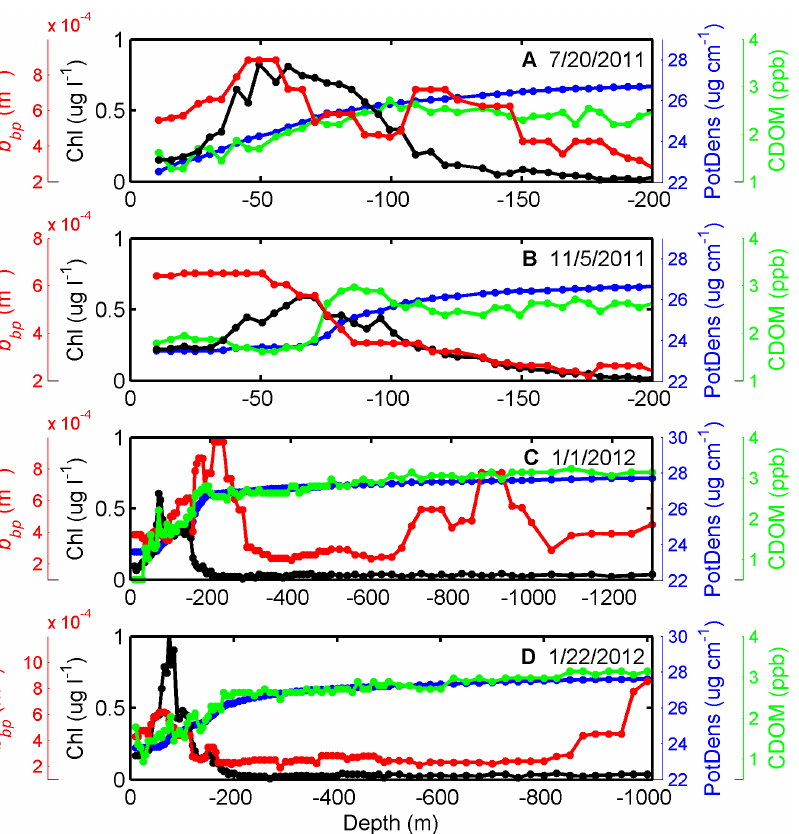
Figure 5. Float profiles exemplifying depth trends and peaks in b bp , Chl, CDOM, and potential density (PotDens). Examples each are provided of b bp peaks at the following depths: (A) coincident with and just below the DCM, (B) in a surface layer, (C) at intermediate depths (700 to 900 m), and (D) near-bottom. In panels A and B, only the upper 200 m of the profiles are shown to emphasize the region of maximum variability in